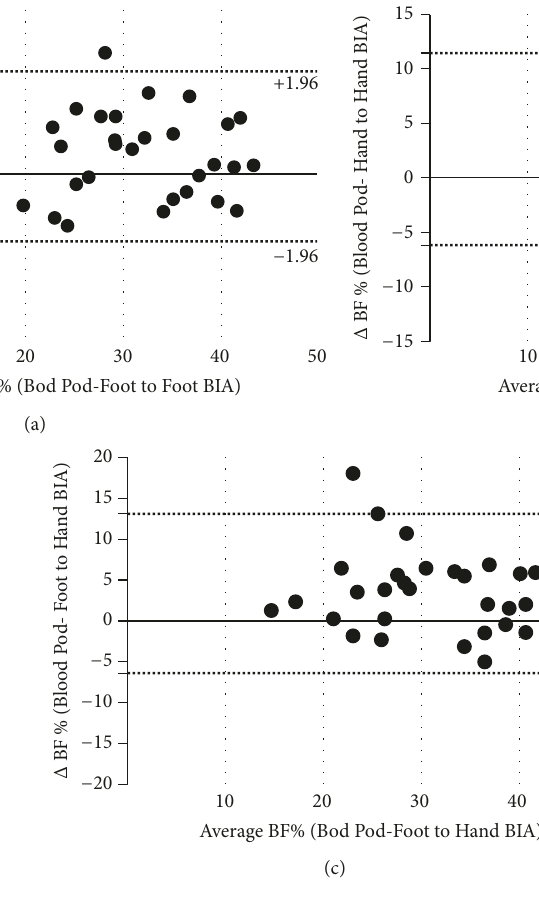
Figure 1: Tertile 3 of Waist Circumference Across BIA